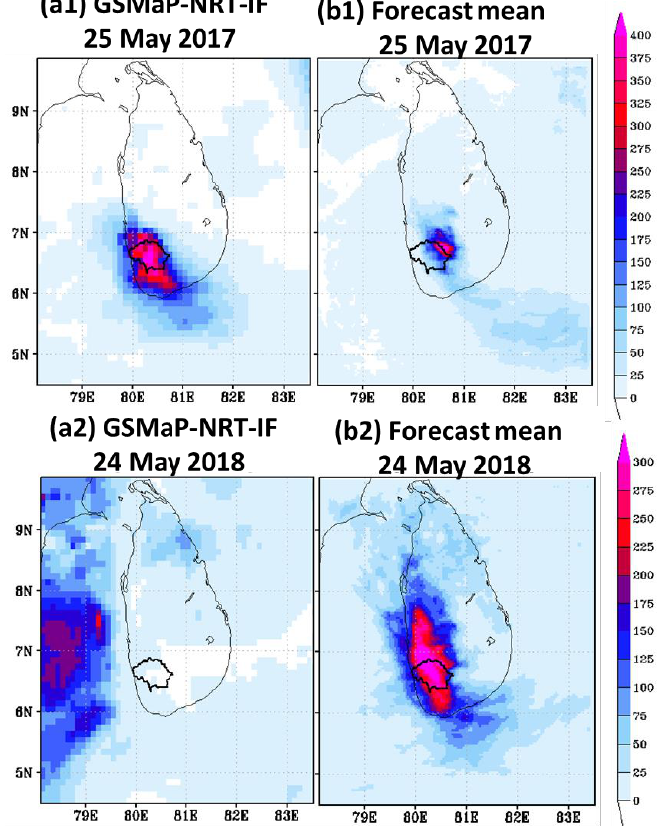
Figure 16. Comparison of daily rainfall (mm/day) distributions: ( a1 ) NRT-IF data for 25 May 2017; ( b1 ) ensemble mean rainfall forecasted at 00 UTC on 24 May 2017 for 25 May 2017; ( a2 ) NRT-IF data for 24 May 2018; and ( b2 ) ensemble mean rainfall forecasted at 00 UTC on 23 May 2018 for 24 May 2018 .